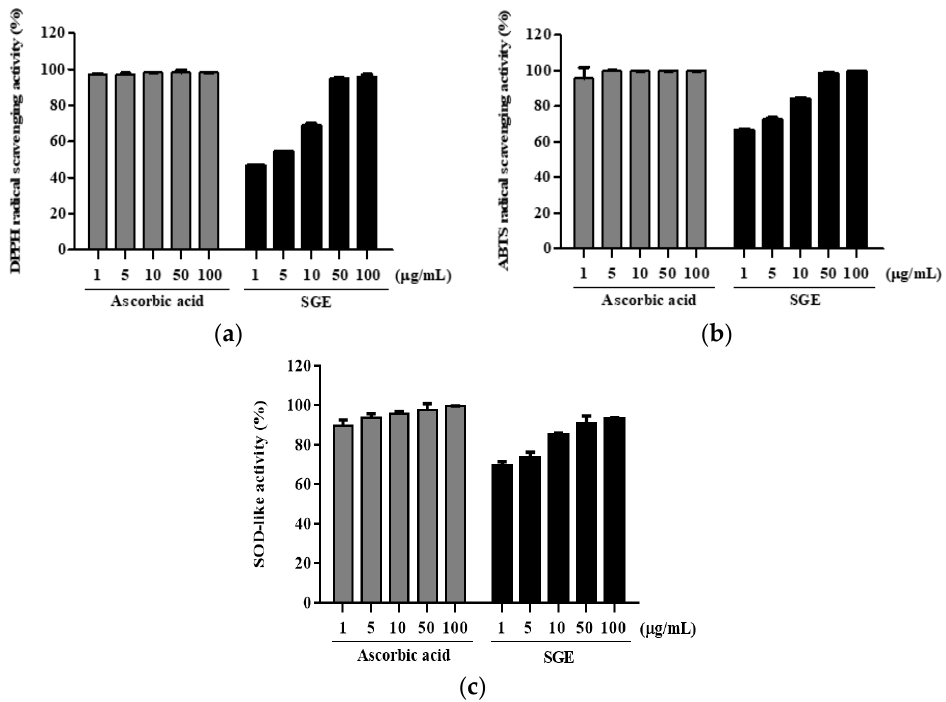
Figure 6. DPPH, ABTS, and SOD-like antioxidation activity of SGE. DPPH radical scavenging ( a ), ABTS + cation scavenging ( b ), and SOD-like activity of SGE ( c ). Ascorbic acid was used as a positive control. Data are expressed as mean ± SD of the results of three